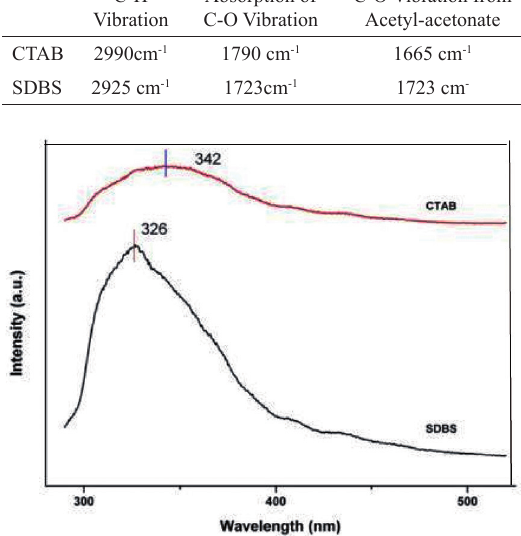
O samples capped 2 3